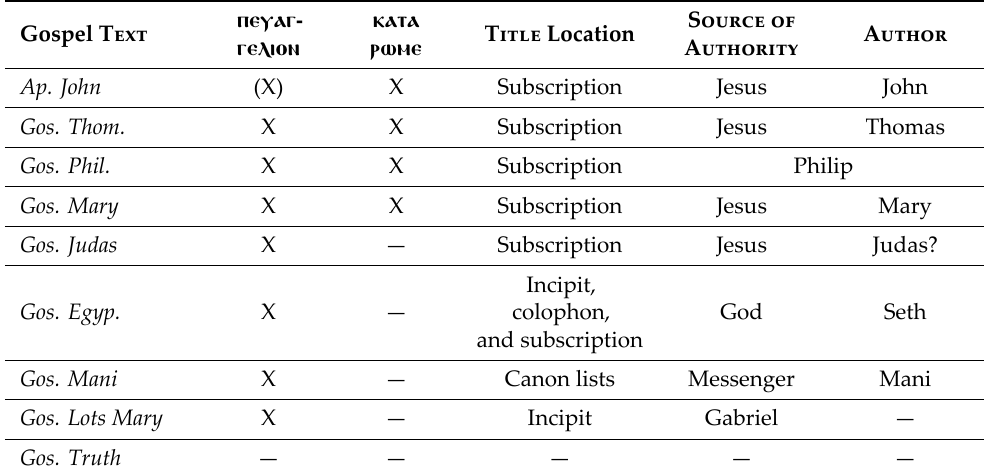
Table 5. Apocryphal Gospels, their TITLE, SOURCE OF AUTHORITY, and